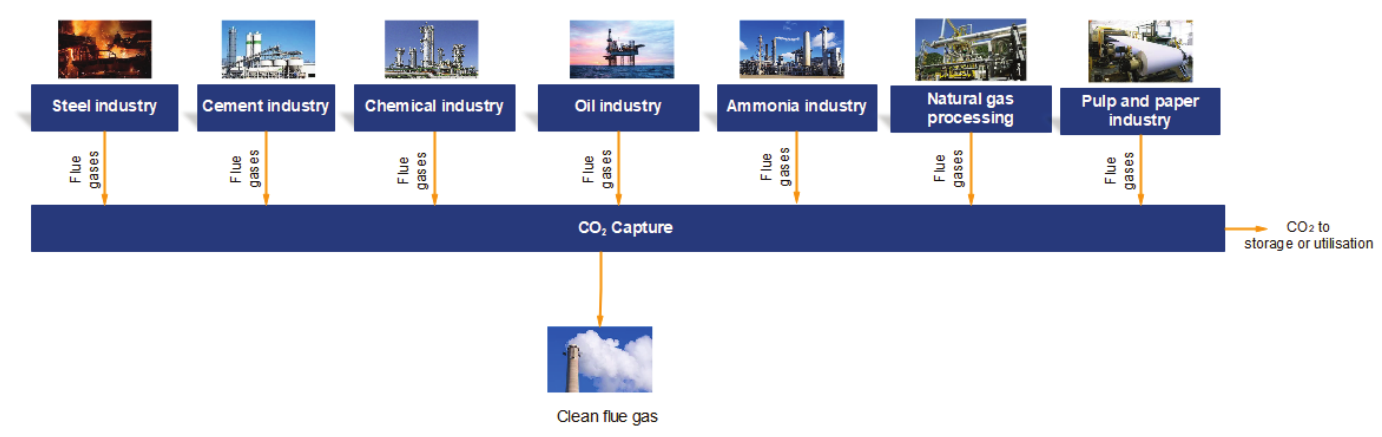
Fig. 1 – Overview of CO